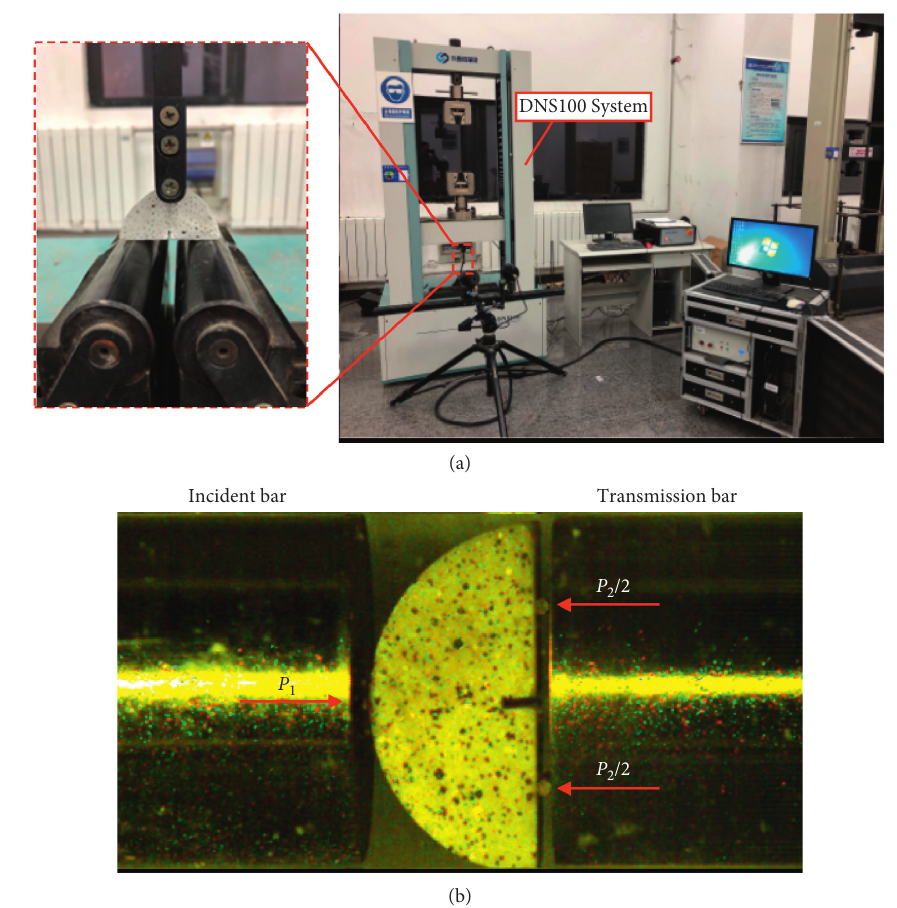
Figure 5: Static and dynamic three-point bending tests. (a) Loading system of the static three-point bending test. (b) Photograph of the dynamic three-point bending